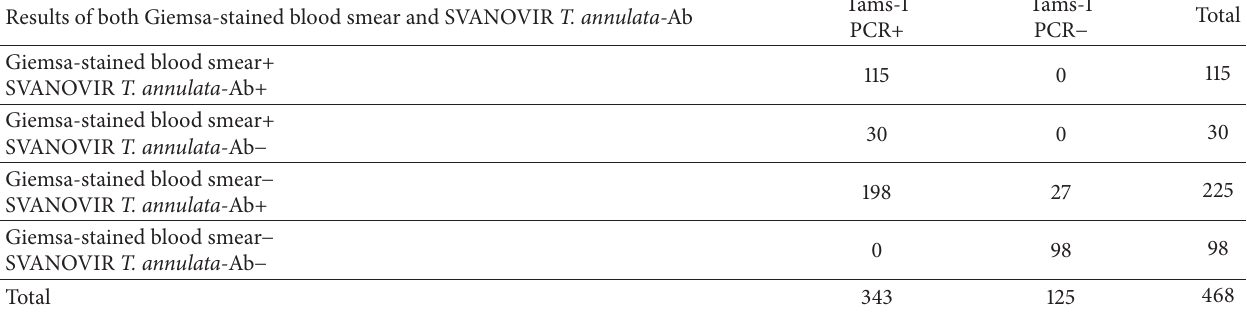
Table 2: Results obtained using all three diagnostic techniques: conventional, serological, and molecular methods. Results of both Giemsa-stained blood smear and SVANOVIR T. annulata -Ab